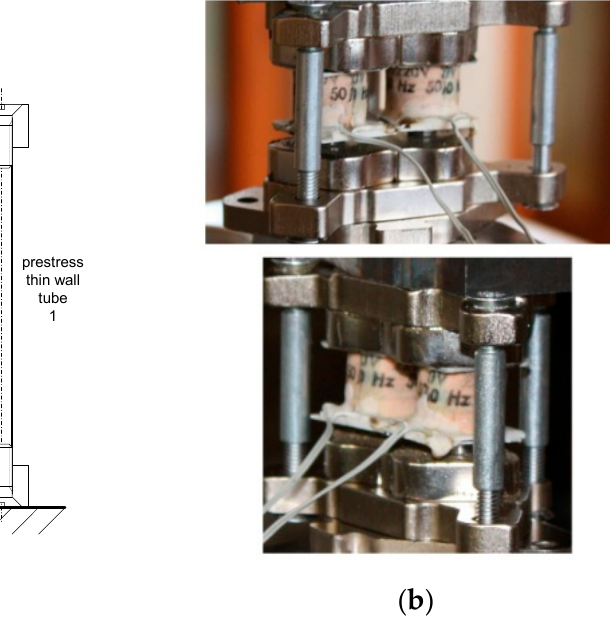
Figure 2. DTCCM harvester: ( a ) scheme, ( b ) real device.